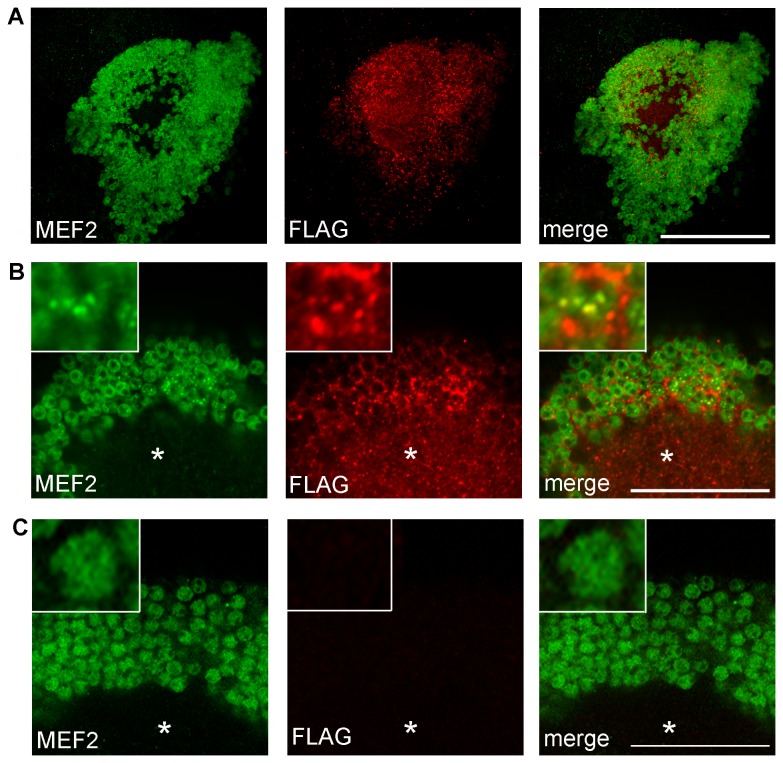
HDAC4 induces relocation of MEF2 in nuclei.A. Confocal projection through the posterior brain showing expression of MEF2 (green) and HDAC4 (red) in Kenyon cells. Scale bar = 50 μm. B. A single confocal plane (1 μm) through the Kenyon cells at the level of the calyx (asterisk) shows MEF2 is localized to the nuclei whereas HDAC4 is predominantly localized to the calyx and cytoplasm. In a subset of cells, nuclear HDAC4 expression is observed, which always co-localizes with MEF2. Inset shows a single cell body with punctate nuclear HDAC4 surrounded by a cytoplasmic halo of HDAC4. MEF2 has been recruited from a relatively even nuclear pattern to the punctate distribution. Scale bar = 25 μm. Inset is at 5.4x magnification. C. In control brains, MEF2 is distributed evenly across the nucleus and punctate localization is not observed, thus overexpression of HDAC4 has caused a redistribution of MEF2 from a relatively even nuclear pattern to a more punctate distribution. Scale bar = 25 μm. Inset is at 5.4x magnification.